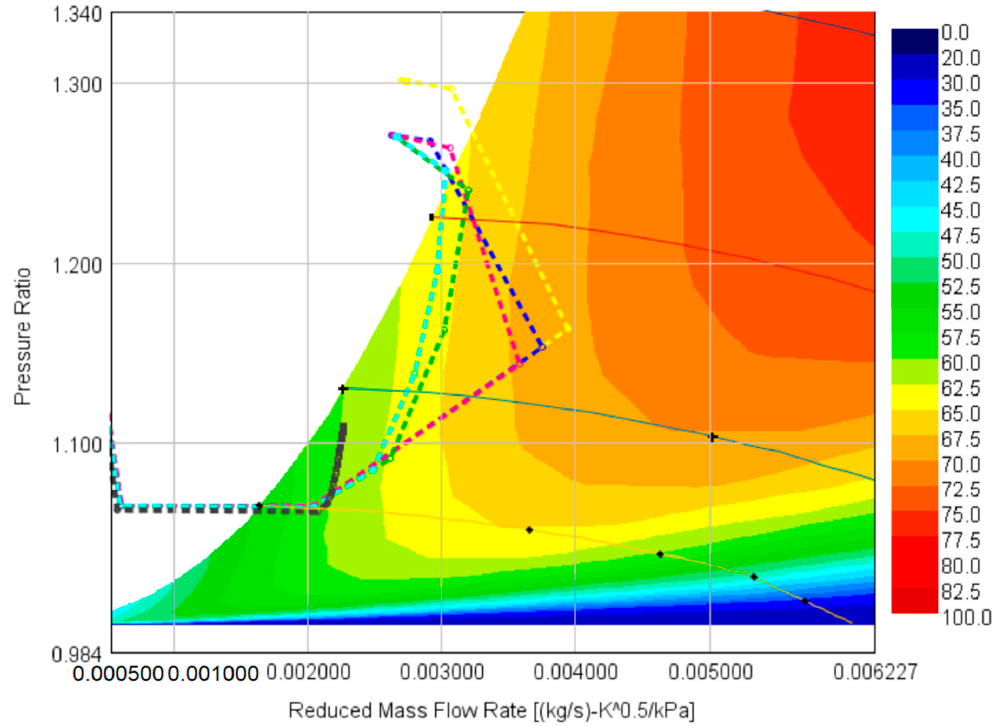
Figure 8. Compressor performance at 1000 rpm engine speed with efficiency